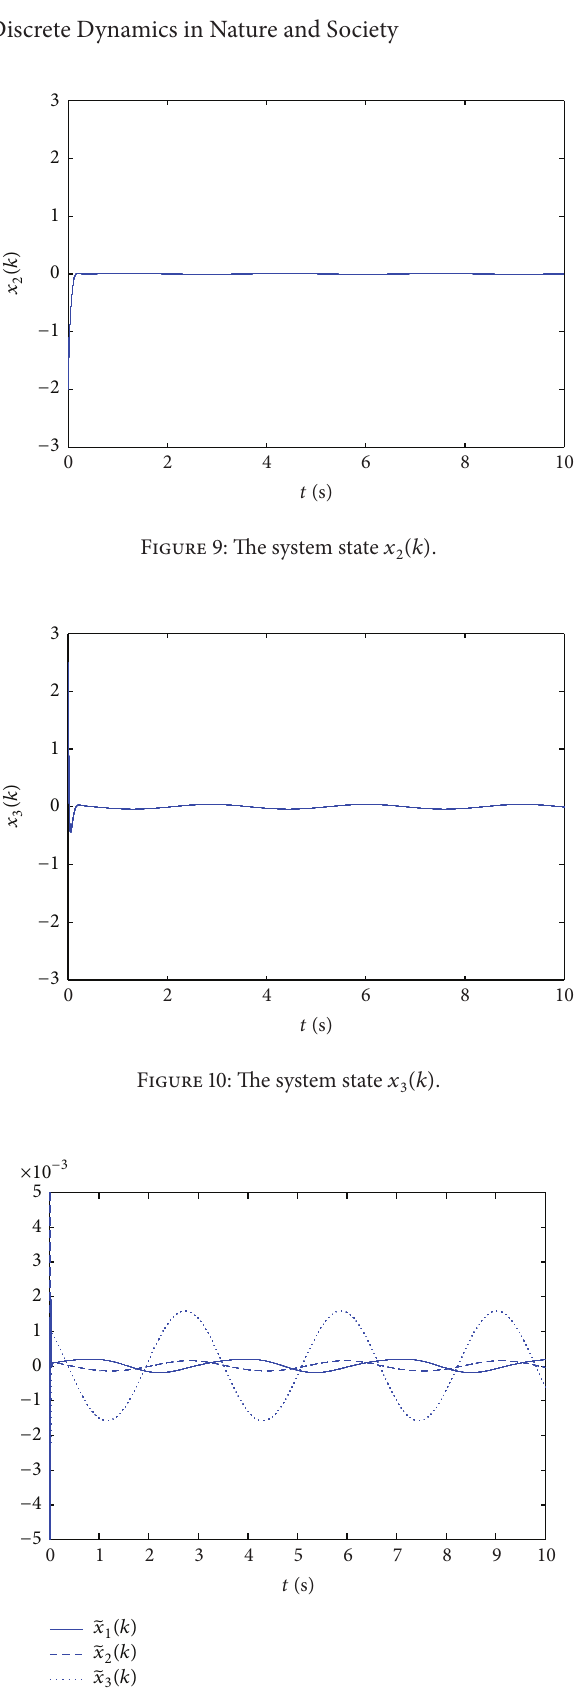
Figure 11: The estimation error outputs of ̃𝑥 1 (𝑘) , ̃𝑥 2 (𝑘) , and ̃𝑥 3 (𝑘) .